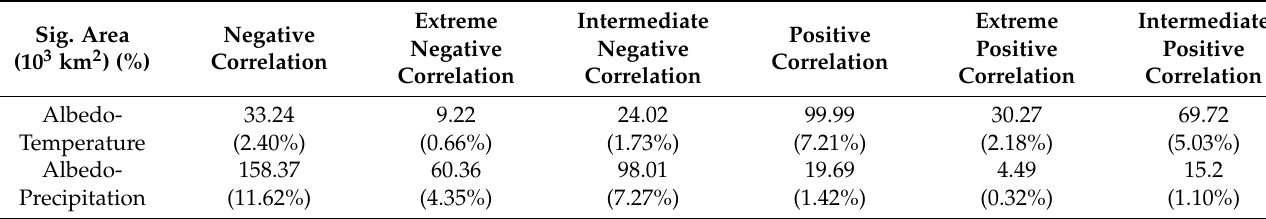
Figure 6. The spatial distribution of annual albedo with ( a ) temperature and ( b ) precipitation and the vertical response model of average annual albedo to average annual ( c ) temperature and ( d ) precipitation for each 1000 m elevation bin during 2000–2015 for the grassland over the QTP (statistically significant results were indicated as for a 95% confidence level (*) and 99% confidence level (**)). Table 3. The areas that showed significant correlations between annual albedo and temperature/precipitation during 2000–2015; the significant correlations include four categories: extreme negative correlation (r < 0, p < 0.01), intermediate negative correlation (r < 0, 0.01 < p < 0.05), intermediate positive correlation (r > 0, 0.01 < p < 0.05) and extreme positive correlation (r > 0, p < 0.01). Sig. Area